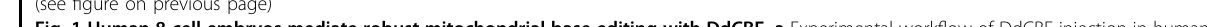
Fig. 1 Human 8-cell embryos mediate robust mitochondrial base editing with DdCBE. a Experimental work fl ow of DdCBE injection in human embryos and genotyping analysis. b Percentage of total sequencing reads with C·G base pair converted to T·A in ND4 -DdCBE-injected 1-cell, 2-cell, 4-cell, and 8-cell embryos of 3PN. c Experimental work fl ow of DdCBE injection for off-target pro fi ling in human 2PN embryos. d On-target ef fi ciency of ND4 -DdCBE in human 2PN embryos. Embryos injected with ND4 -Dead-DdCBE + GFP or only GFP mRNA showed no base editing on the ND4 site. e Mitochondrial genome-wide off-target loci identi fi ed from human 2PN embryos injected with ND4 -DdCBE. No SNV was identi fi ed in control embryos injected with ND4 -Dead-DdCBE + GFP or GFP mRNA only whereas several SNVs were identi fi ed in embryos injected with both GFP and ND4 -DdCBE mRNA, possibly due to off-target editing. f Sequence logos generated from sequences with off-target C·G to T·A conversions by ND4 - DdCBE on mitochondrial DNA genome. Bits re fl ect sequence conservation at a given position. g Normal morphology of human 2PN embryos injected with ND4 -DdCBE at different developmental stages. h Comparable developmental rate between uninjected human 2PN embryos and the ones injected with ND4 -DdCBE. Data are presented as means ± SEM. P values were evaluated with the unpaired student ’ s t -test